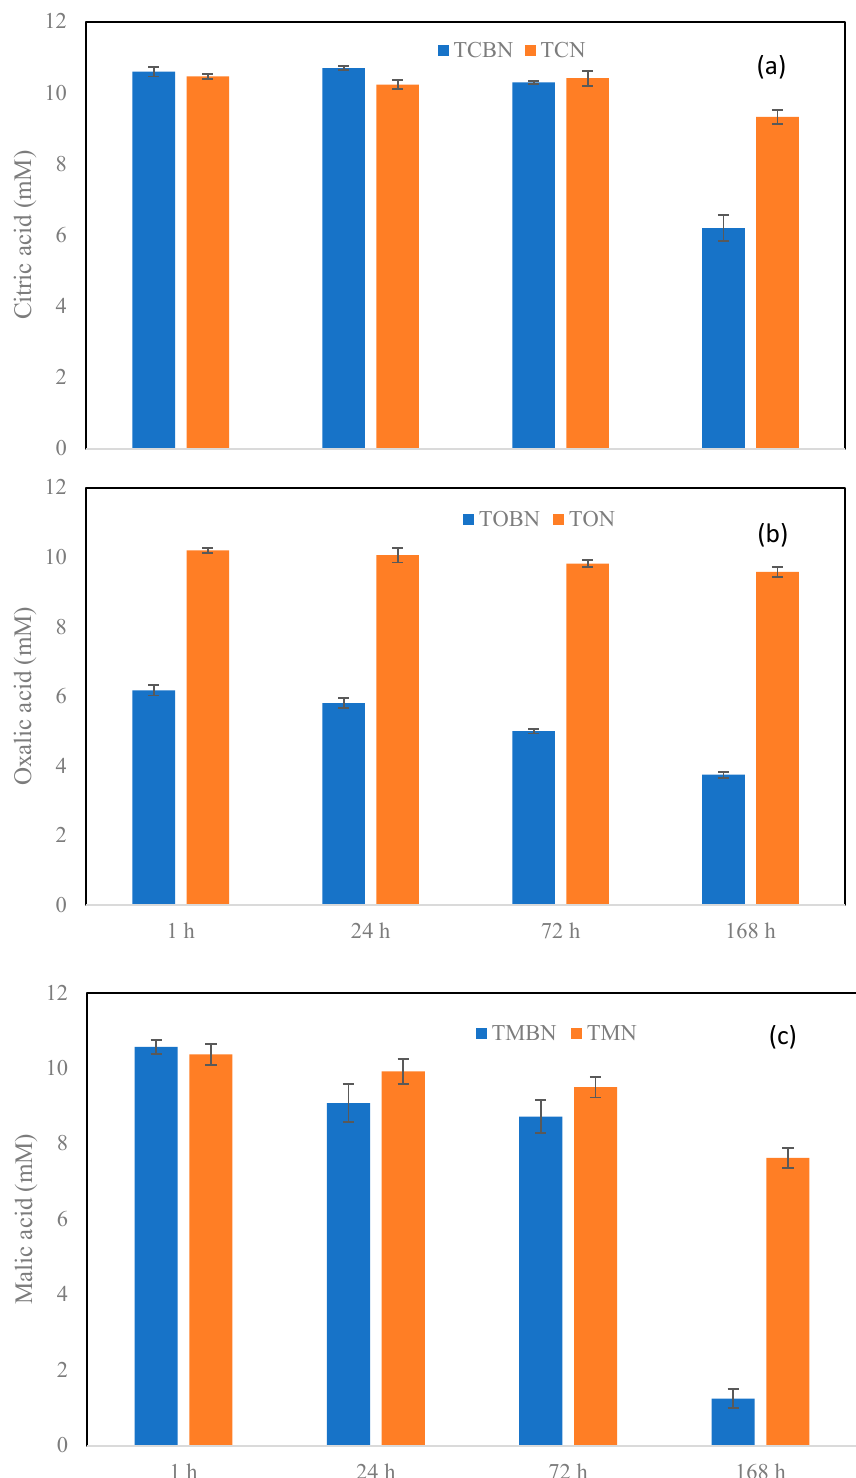
Figure 1. Temporal variation in ( a ) citrate, ( b ) oxalate, and ( c ) malate in the LMWOA only and LMWOA–biochar treatment systems during the period of experiment.